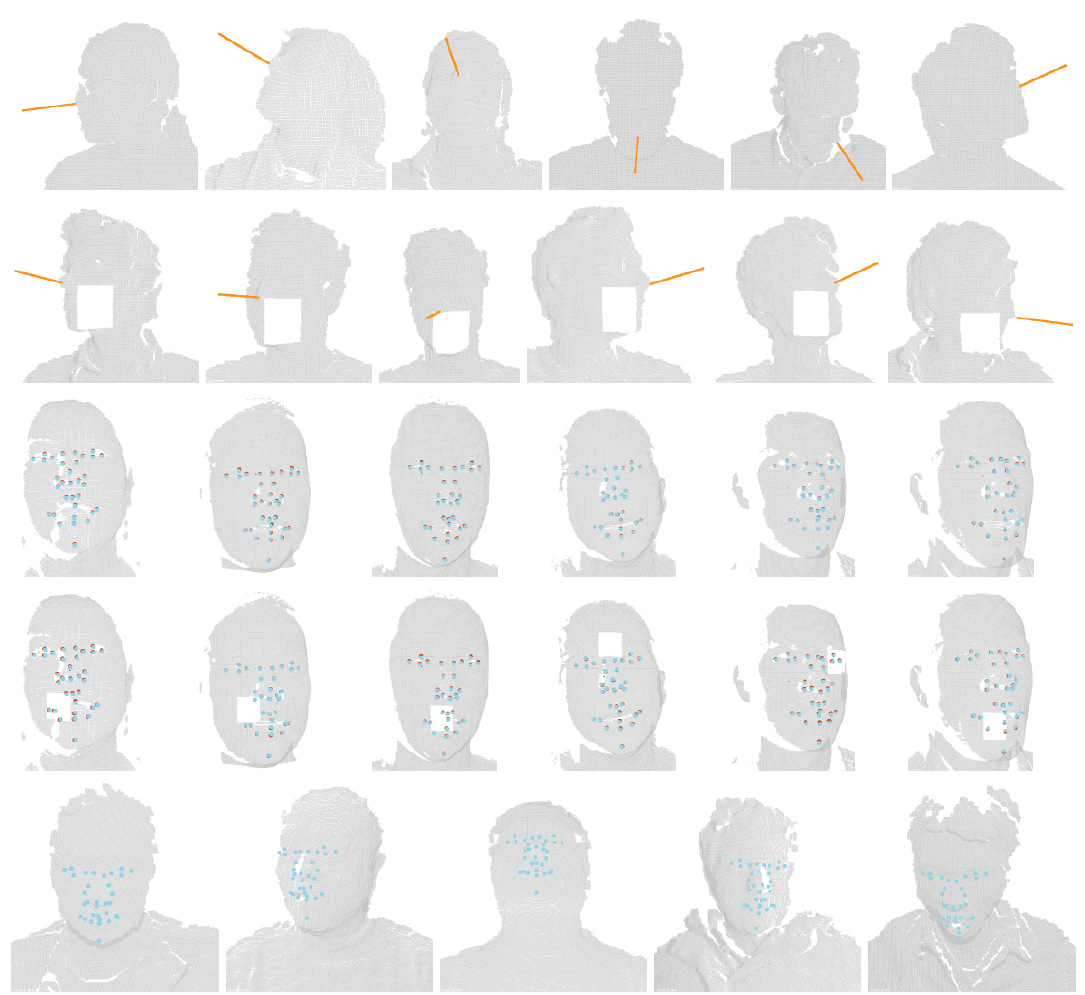
Fig. 10 Robustness of the proposed method to occlusion. Top two rows: results of head pose estimation on the BIWI database. Next two rows: facial landmark results on the B3D(AC) 2 database. Red points: ground truth shape. Blue points: estimated shape. Blank areas in the depth images in the second and fourth rows represent parts removed from the input data. Last row: facial landmark localization results for large pose angles, using 3DFEP. To show face shapes clearly, we have adjusted the corresponding point cloud to a suitable